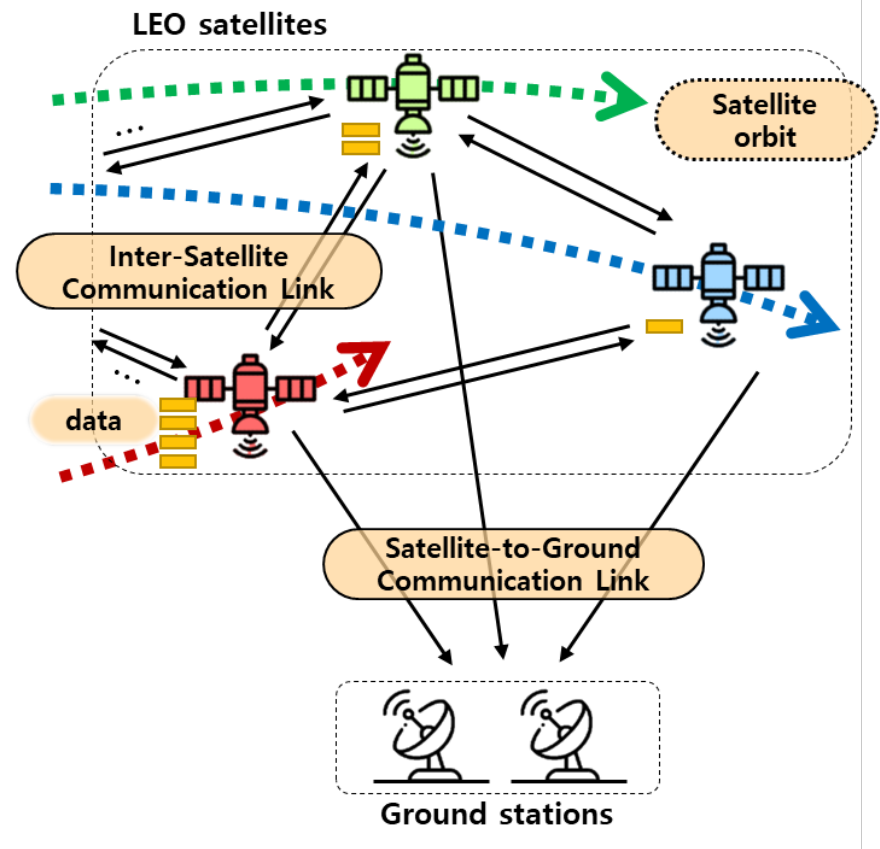
Figure 1. System